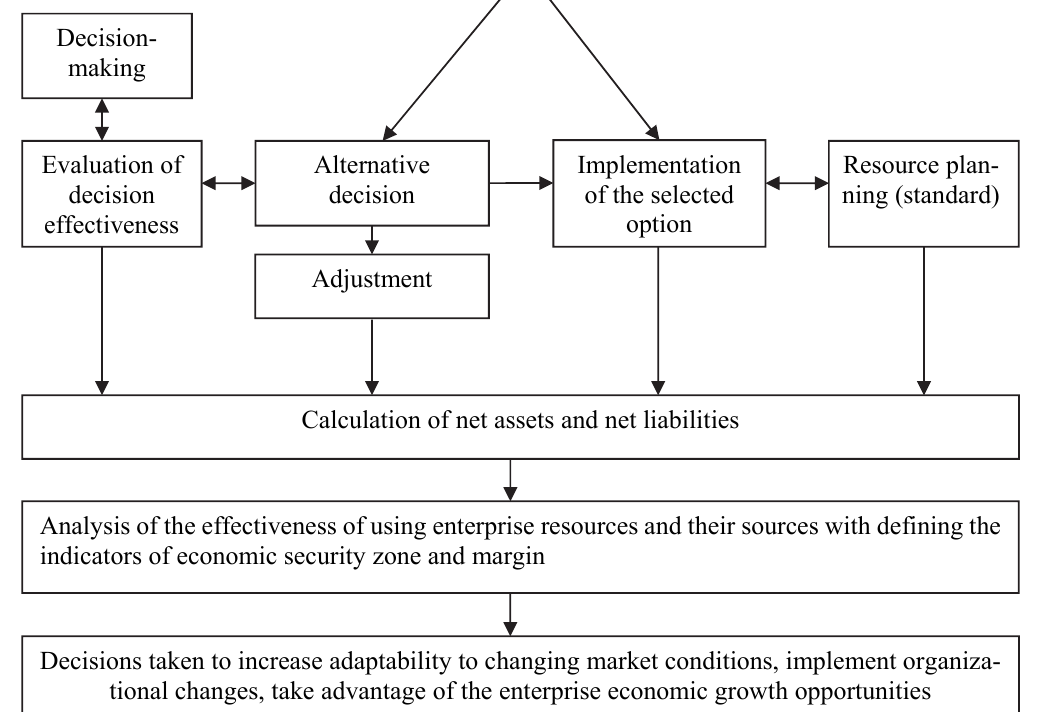
Fig. 2. The usage of results of managing enterprise economic safety based on adaptive engineering